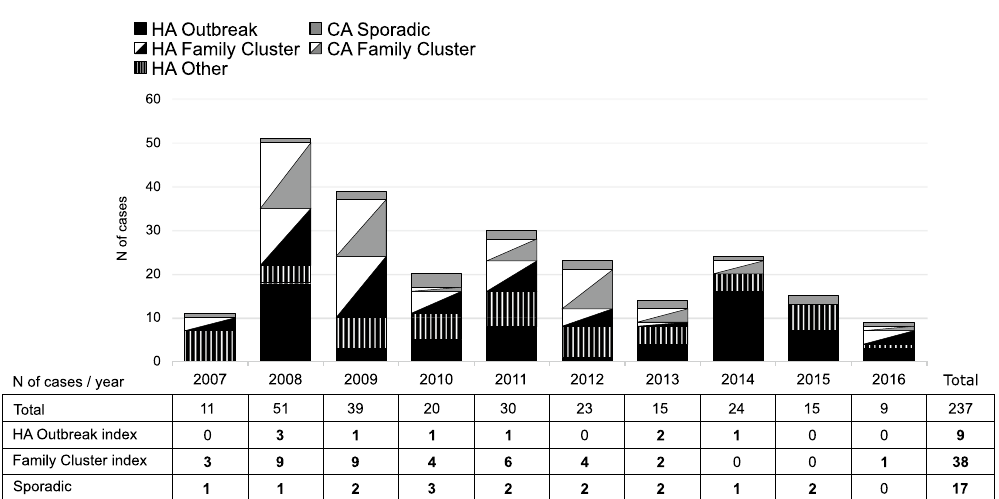
Figure 2. Epidemiological classification and the total number of index/sporadic t172 MRSA cases (n = 273) in the Hospital District of Southwest Finland, years 2007–2016. All t172 index cases and sporadic cases were selected for the WGS based analysis (bold). Healthcare-associated/Community-associated